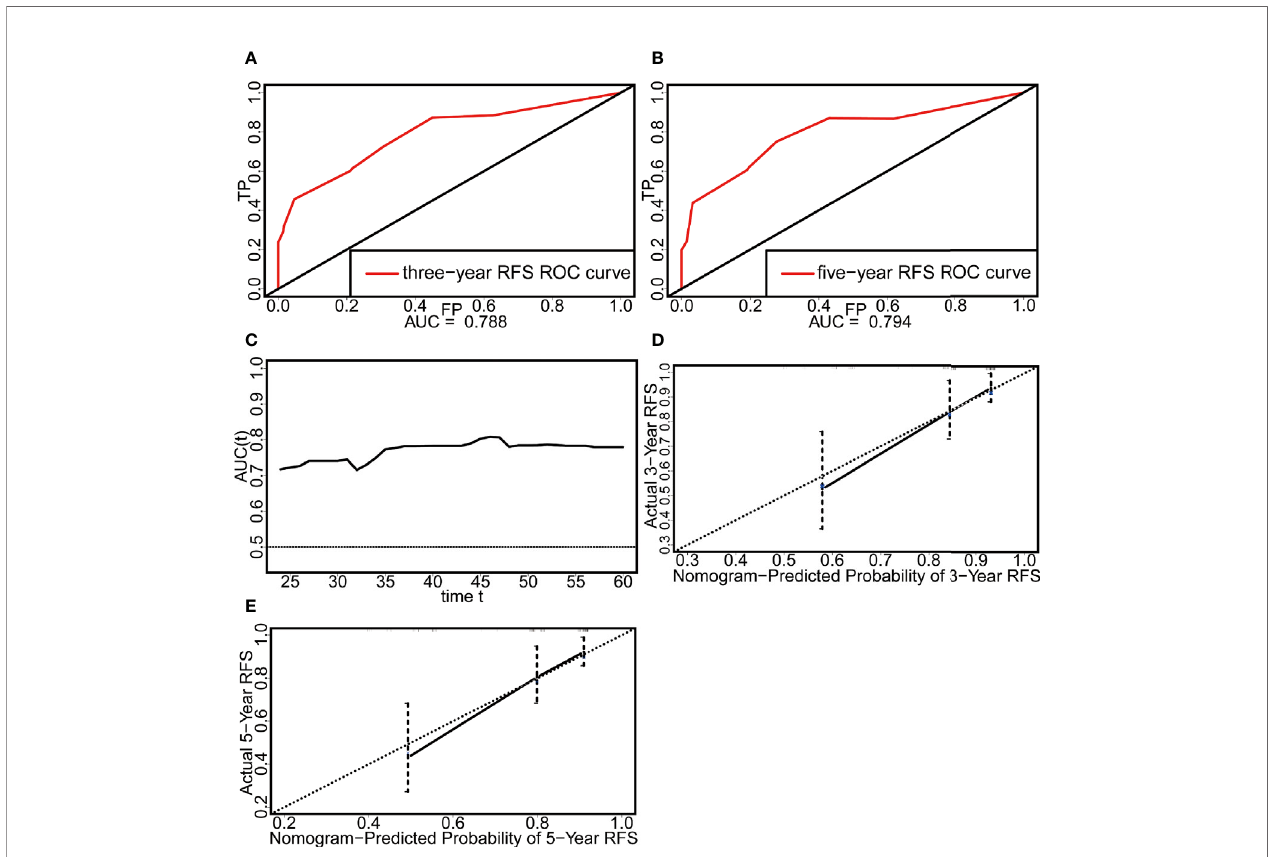
FIGURE 4 | Evaluation of the discrimination and calibration of the nomogram in the external validation set. (A) The ROC curve of three-year RFS. (B) The ROC curve of fi ve-year RFS. (C) The time-dependent ROC curve. (D) The calibration plot of three-year RFS. (E) The calibration plot of fi ve-year